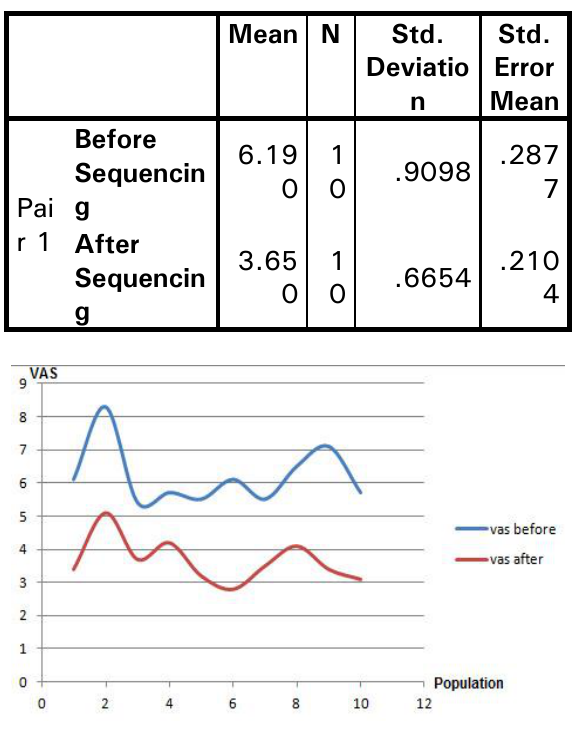
Figure 2: Difference between the individual Visual Analogue Scores before and after